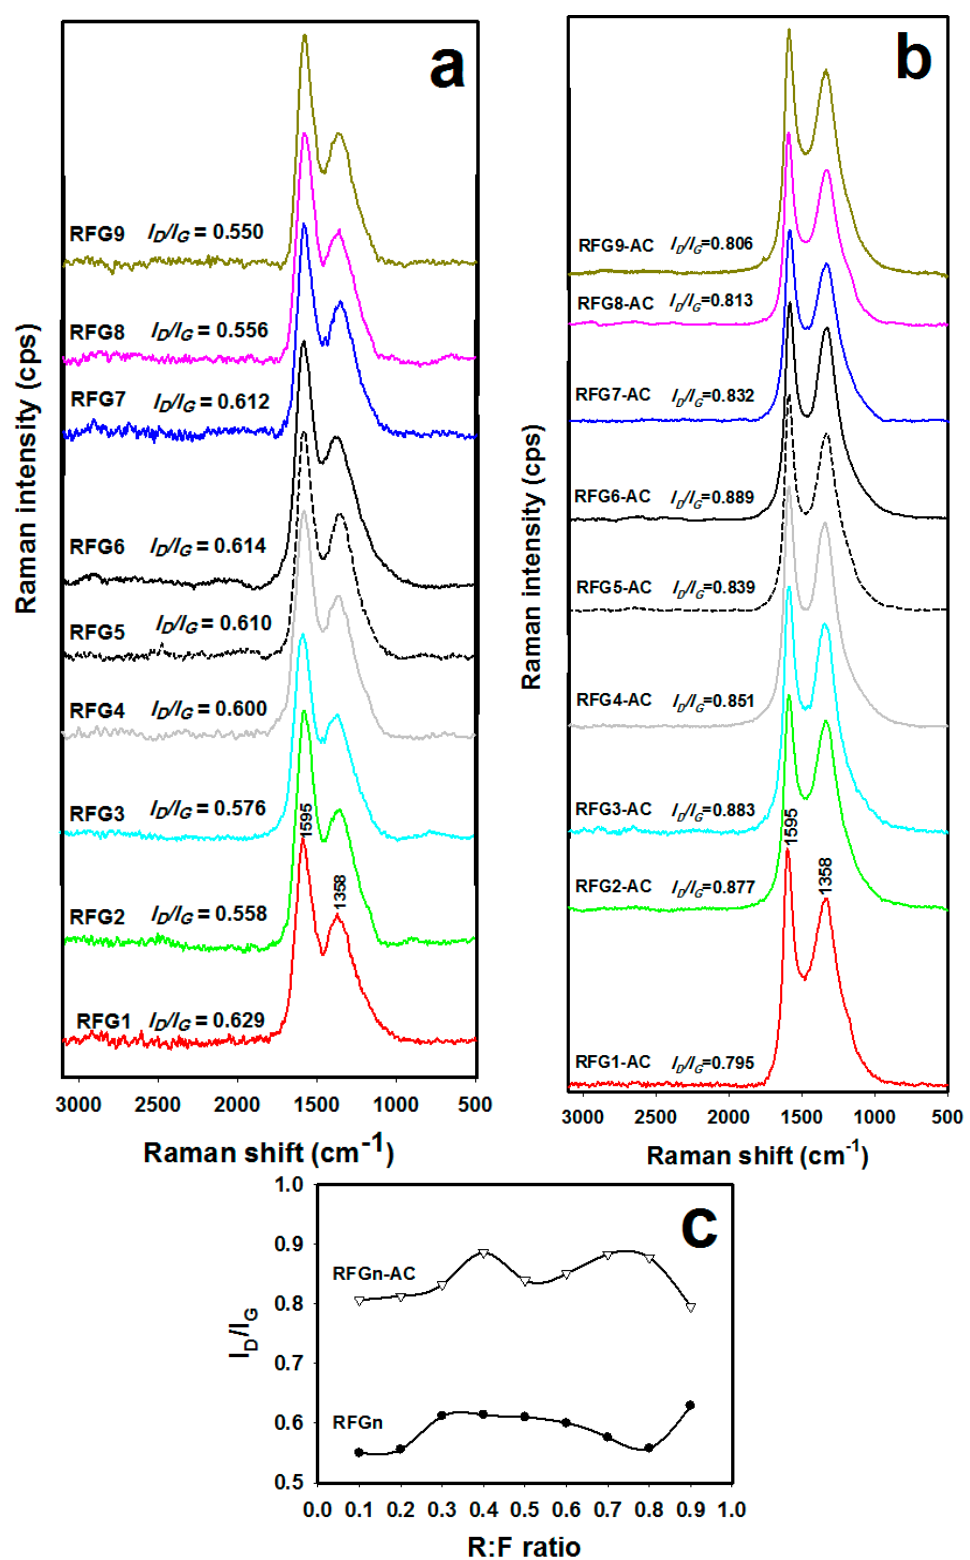
Figure 4. Raman spectra of RFG n and RFG n -AC samples (subfigures a and b , respectively); ( c ) the variation of I d /I G ratios of RFG n and RFG n -AC samples with the corresponding precursor R:F ratios.